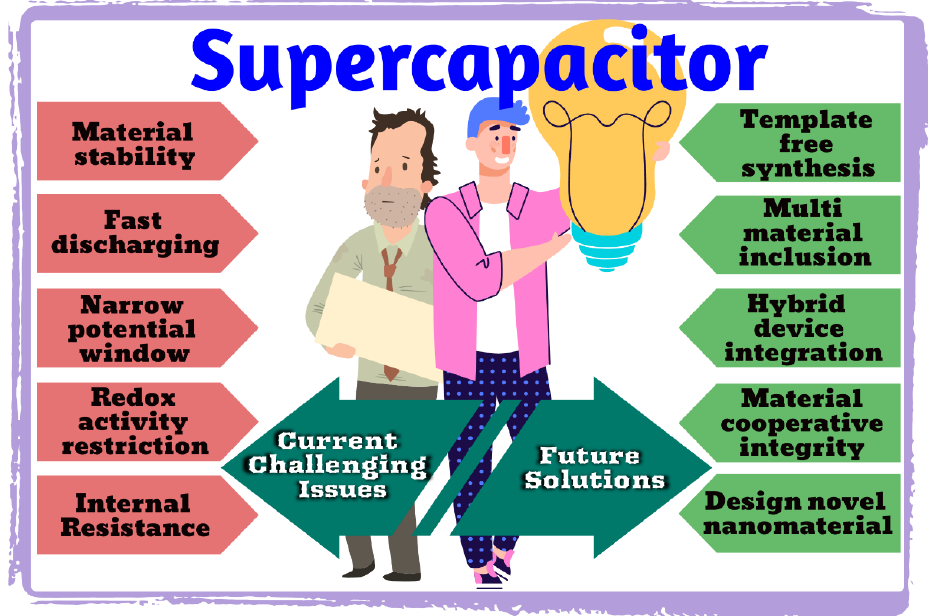
Figure 14. Schematic of several current challenges and future solutions to obtaining highly applica- ble supercapacitor